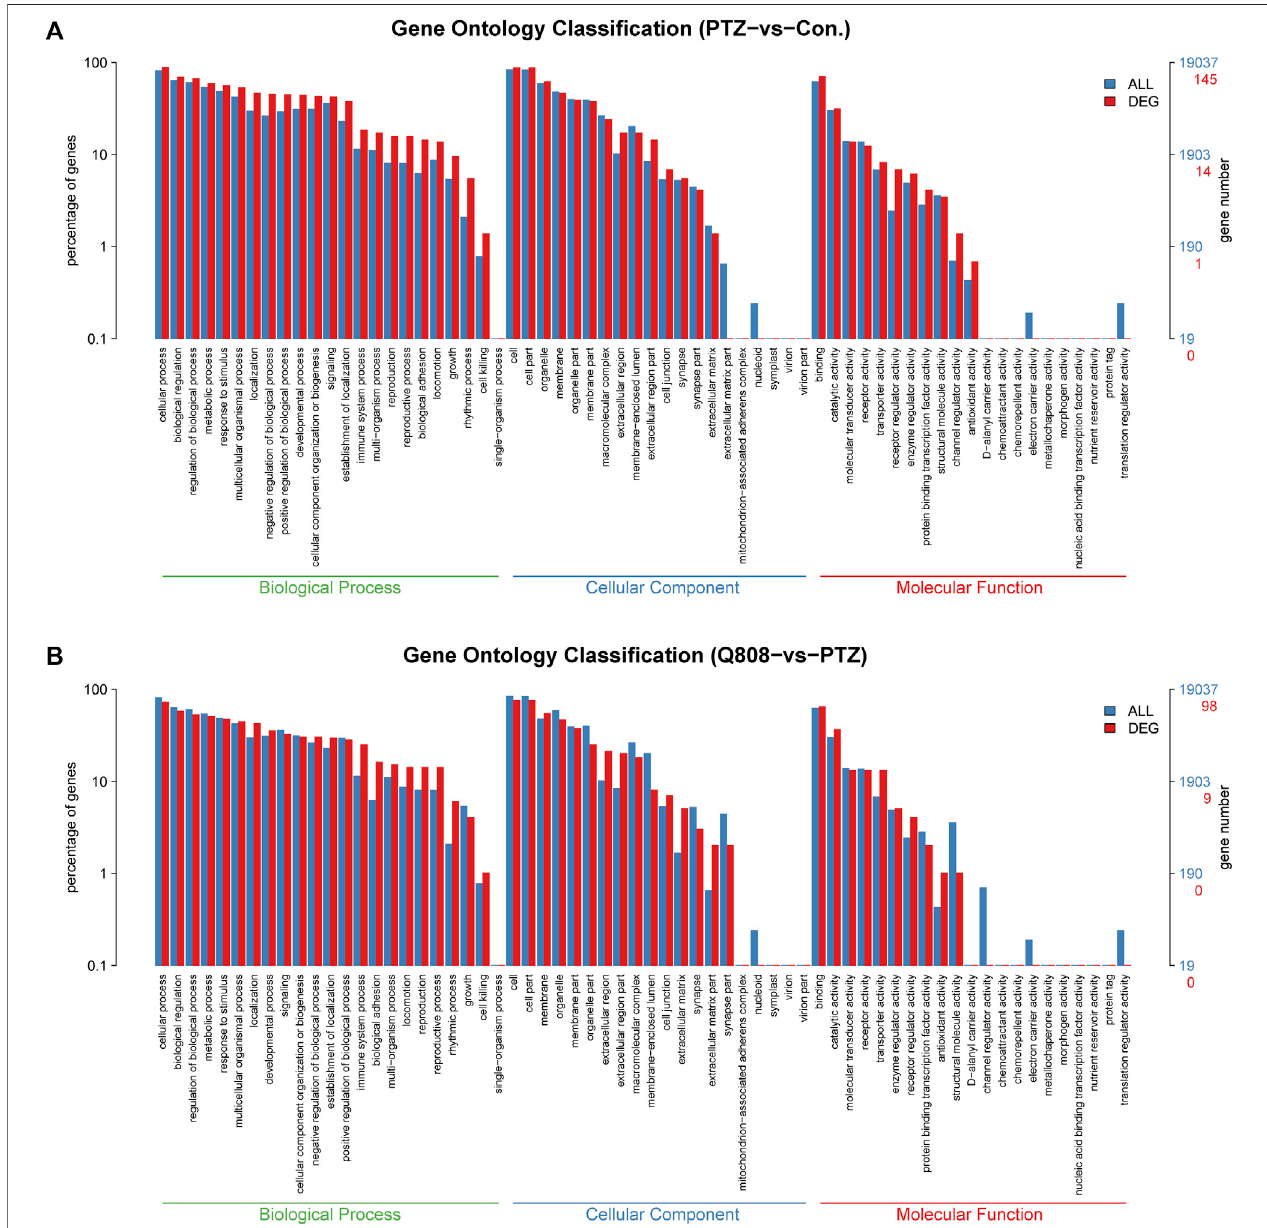
FIGURE4|(A) GOclassi fi cation ofDEGsbetweenPTZand Con.groups. (B) GOclassi fi cation ofDEGsbetweenQ808andPTZgroups. TheGOterm ofthemost genes was cellular process, cell, and binding for the biological process, cellular component, and molecular function,